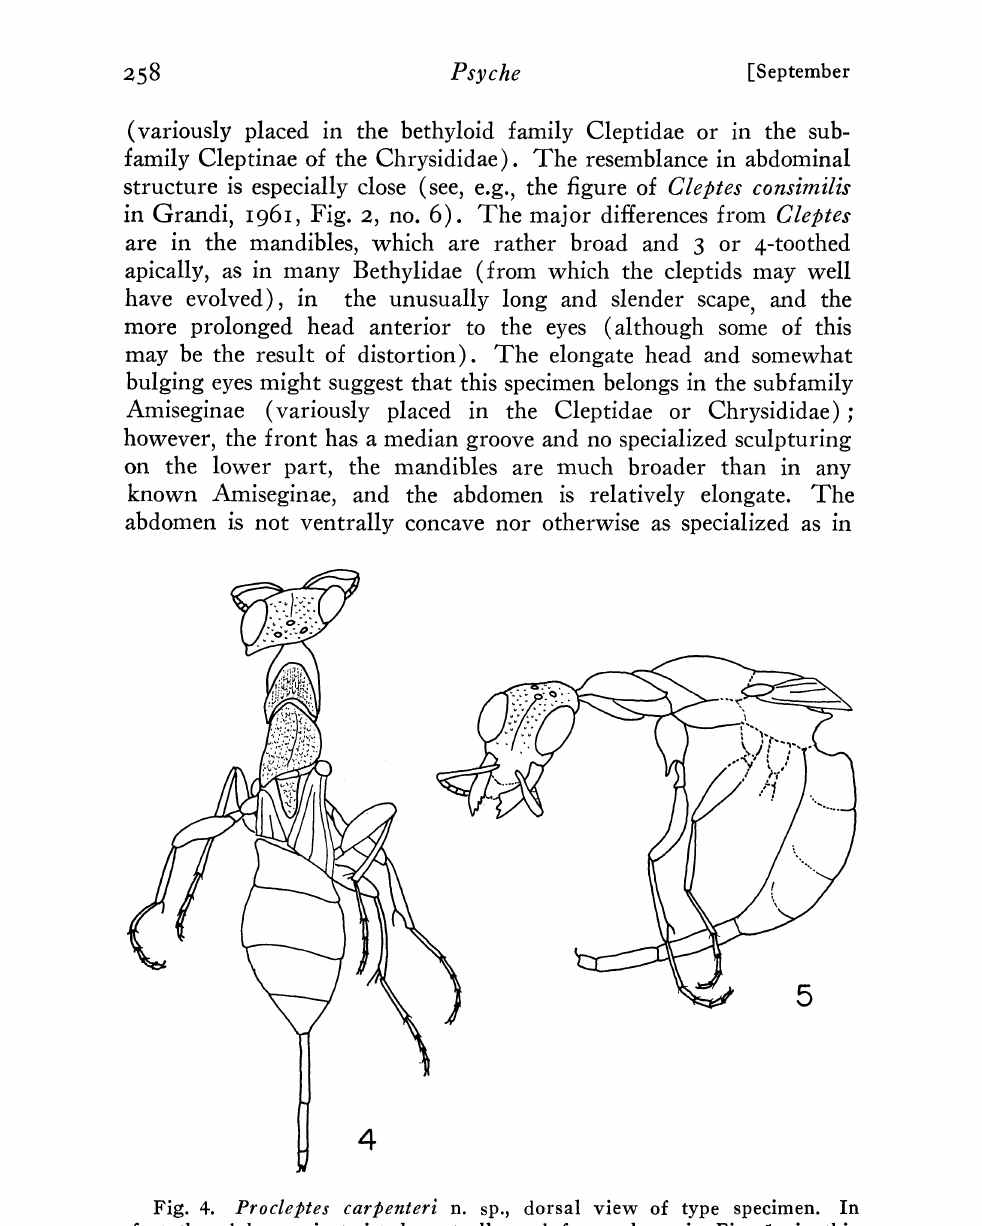
Fig. 4. Procleptes carpenteri n. sp., dorsal view of type specimen. In aet the abdomen is twisted ventrally and forward, as in Fig. 5; in this figure it is shown as if it extended straight backward. Fig. 5. Same specimen, lateral